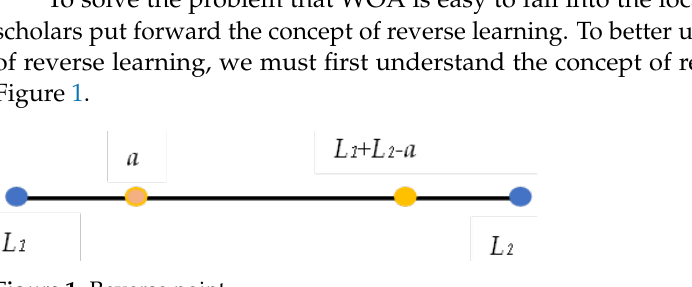
Figure 1. Reverse Figure 1. Reverse point .